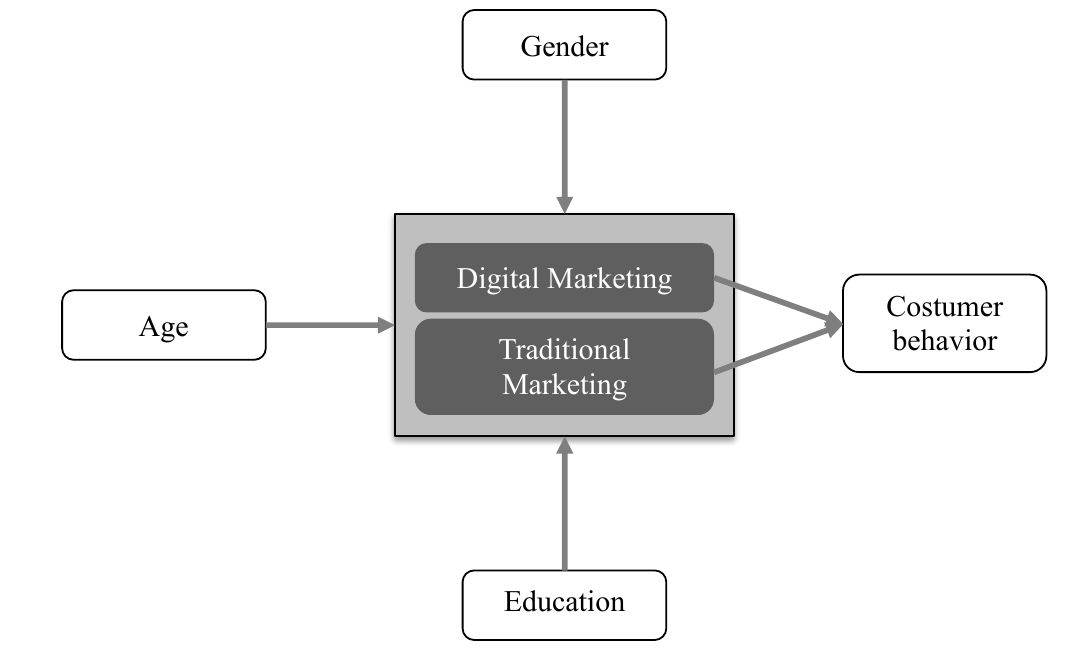
Figure 2. Flowchart of research methodology